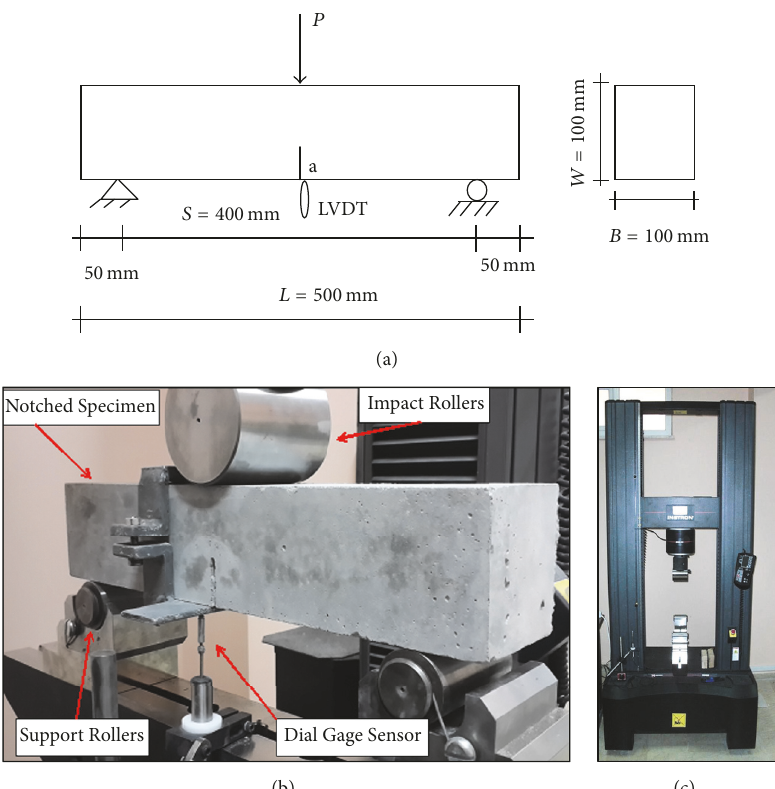
Figure 2: (a) Geometry of the three-point bending specimens used, (b) three-point testing schematic for flexural strength and fracture tests, and (c) test setup and